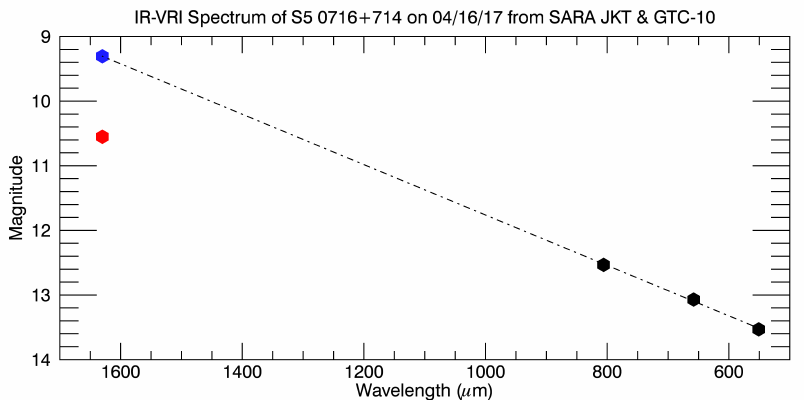
Figure 8. The VRI data (black dots) from SARA JKT averaged over the ∼ 4 h observation. Can see comparison of extrapolated H magnitude vs. measured by CIRCE (red